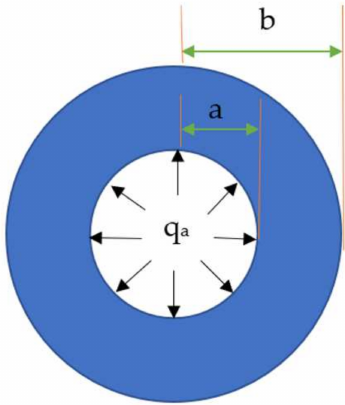
Figure 1. Meso-mechanical model of the asphalt mixture frost